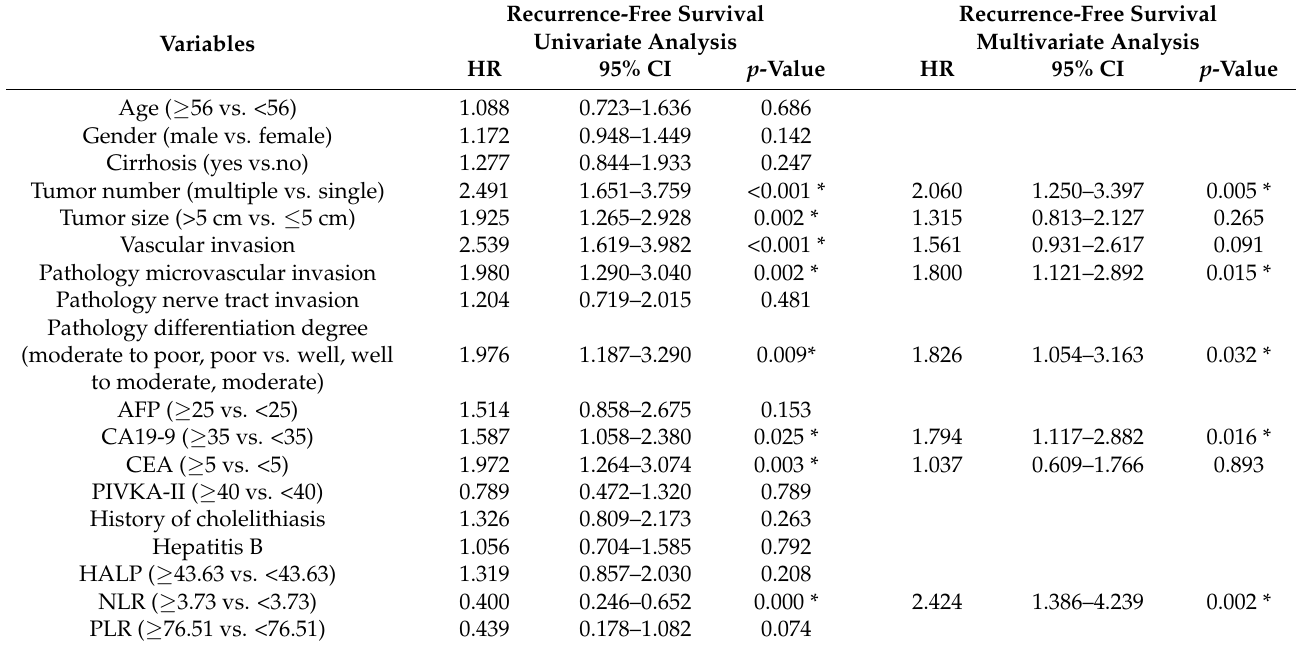
Table 3. Univariate and multivariate analysis for RFS in patients with